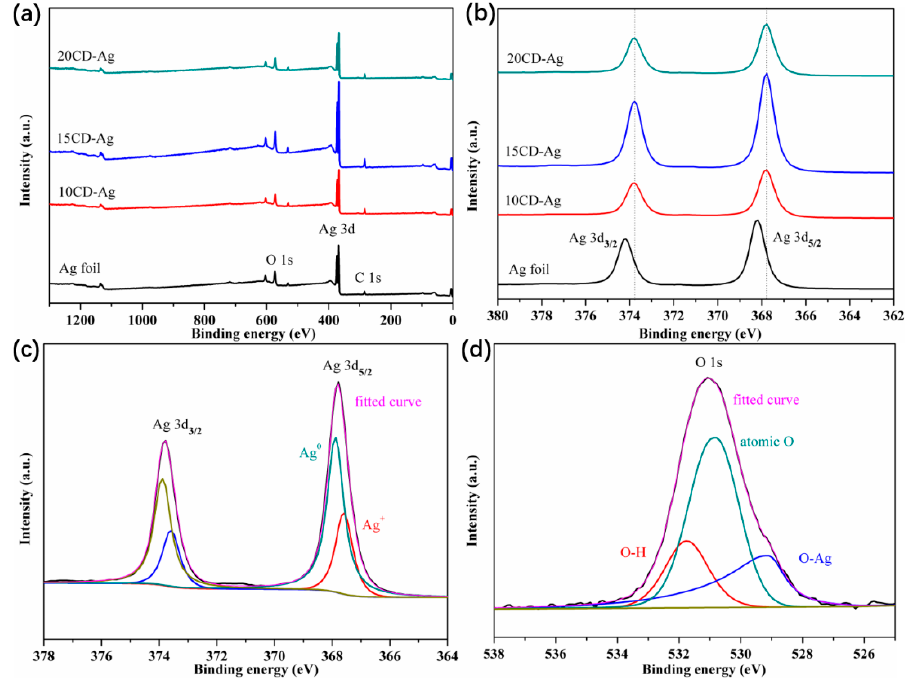
Figure 3. XPS spectra of ( a ) wide scan region and ( b ) Ag 3d of Ag foil and three different CD-Ag materials; the deconvoluted peak of ( c ) Ag 3d and ( d ) O 1s of 15 CD-Ag material.